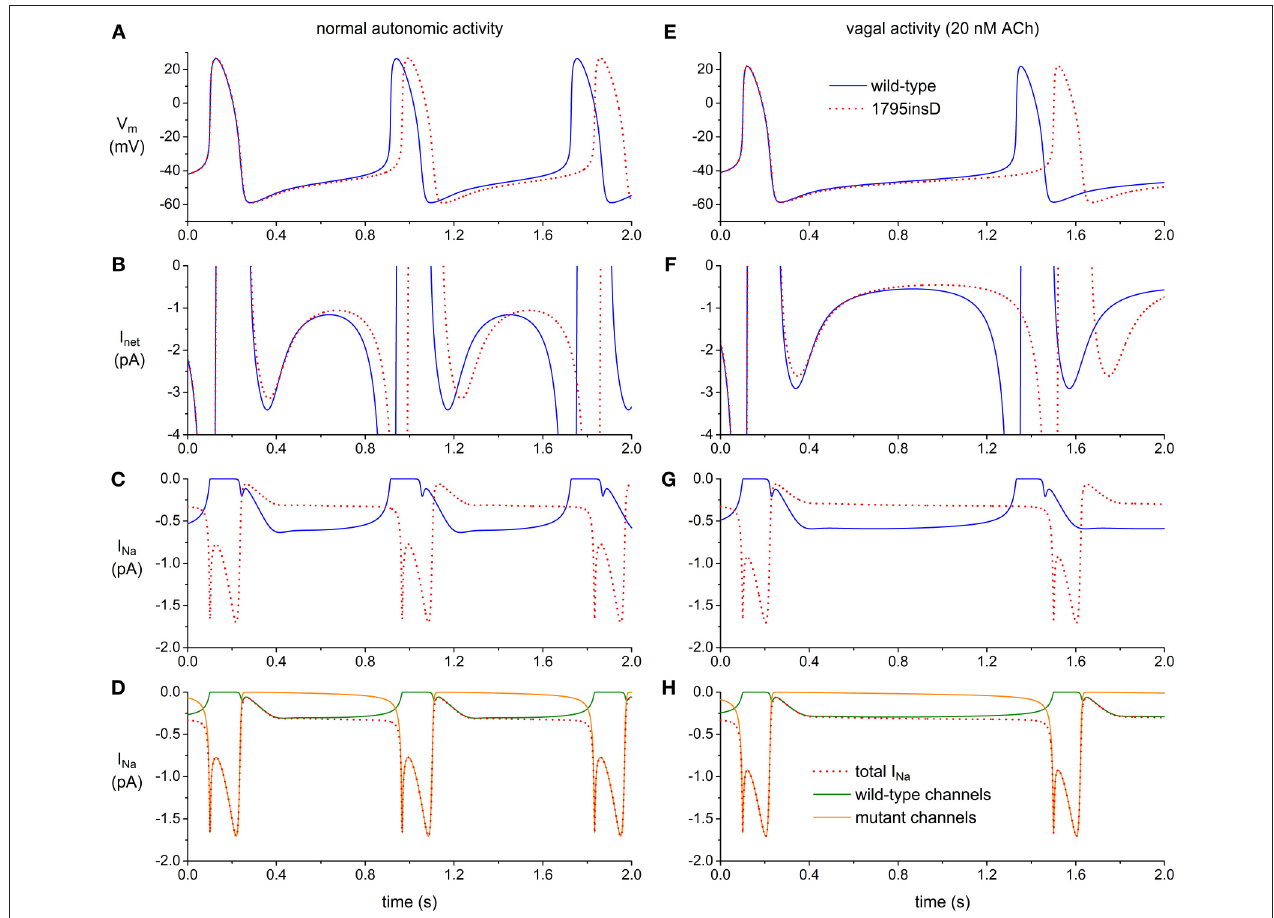
FIGURE 1 | Effect of the 1795insD mutation in SCN5A on the electrical activity of the Fabbri–Severi model cell of a human SAN pacemaker cell (A–D) under control conditions (normal autonomic activity) and (E–H) during vagal activity [based on data from recent computer simulations ( 29)]. (A,E) Membrane potential (V m ) of wild-type and mutant cell (solid blue and dotted red trace, respectively). (B,F) Associated net membrane current (I net ). ( C,G ) Associated fast Na + current (I Na ). (D,H) Contribution of wild-type and mutant channels (solid green and orange trace, respectively) to I Na of the mutant cell (dotted red trace).